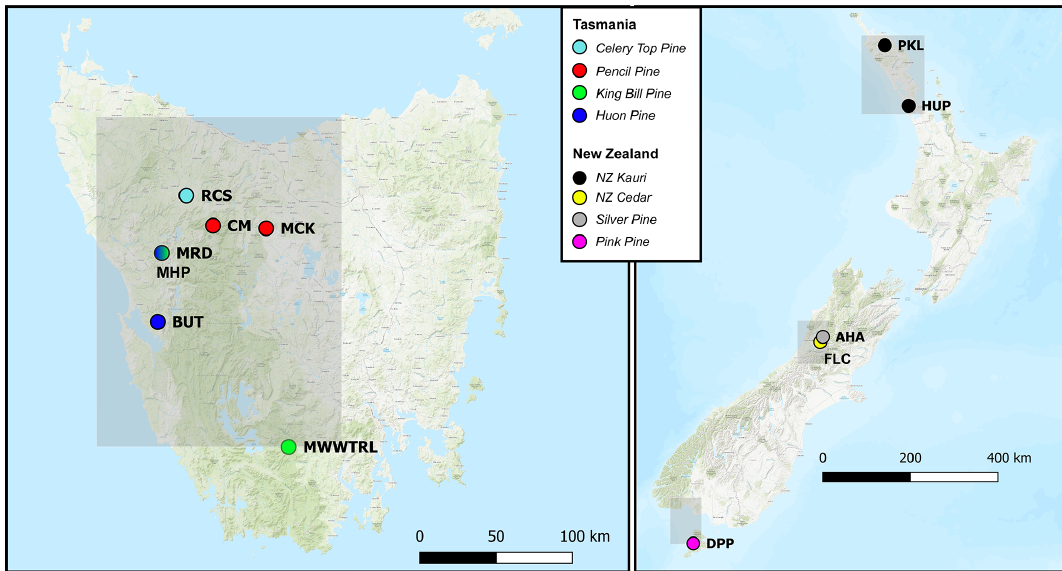
Figure 1. Location map (basemap ESRI 2021) of the tree-ring sites used in this study (see Table 1). Also indicated (grey boxes) are the regional domains of the gridded CRUTS 4.03 temperature and precipitation data (Harris et al., 2014) used for analyses. Tasmania: 41–43 ◦ S, 145–147 ◦ E; New Zealand: north: 35–37 ◦ S, 173–175 ◦ E; central: 42–43 ◦ S, 171–172 ◦ E; south: 46–47 ◦ S, 167–168 ◦